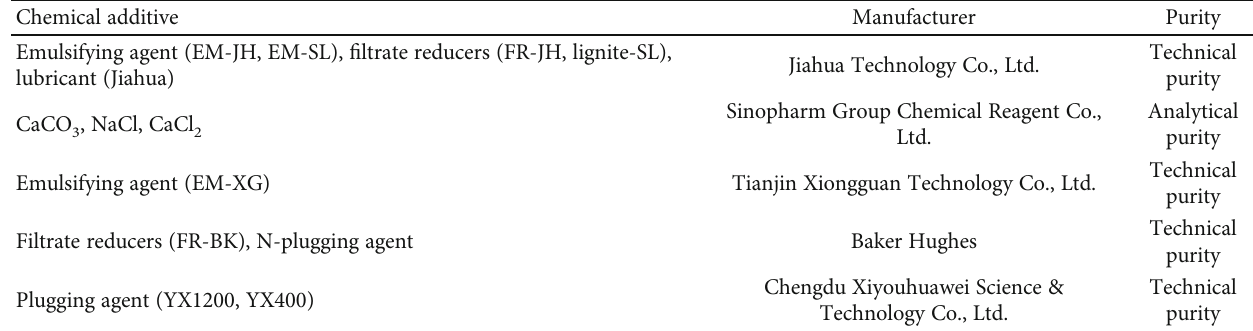
Table 1: Various chemical additives used in the experiments and corresponding manufacturers.